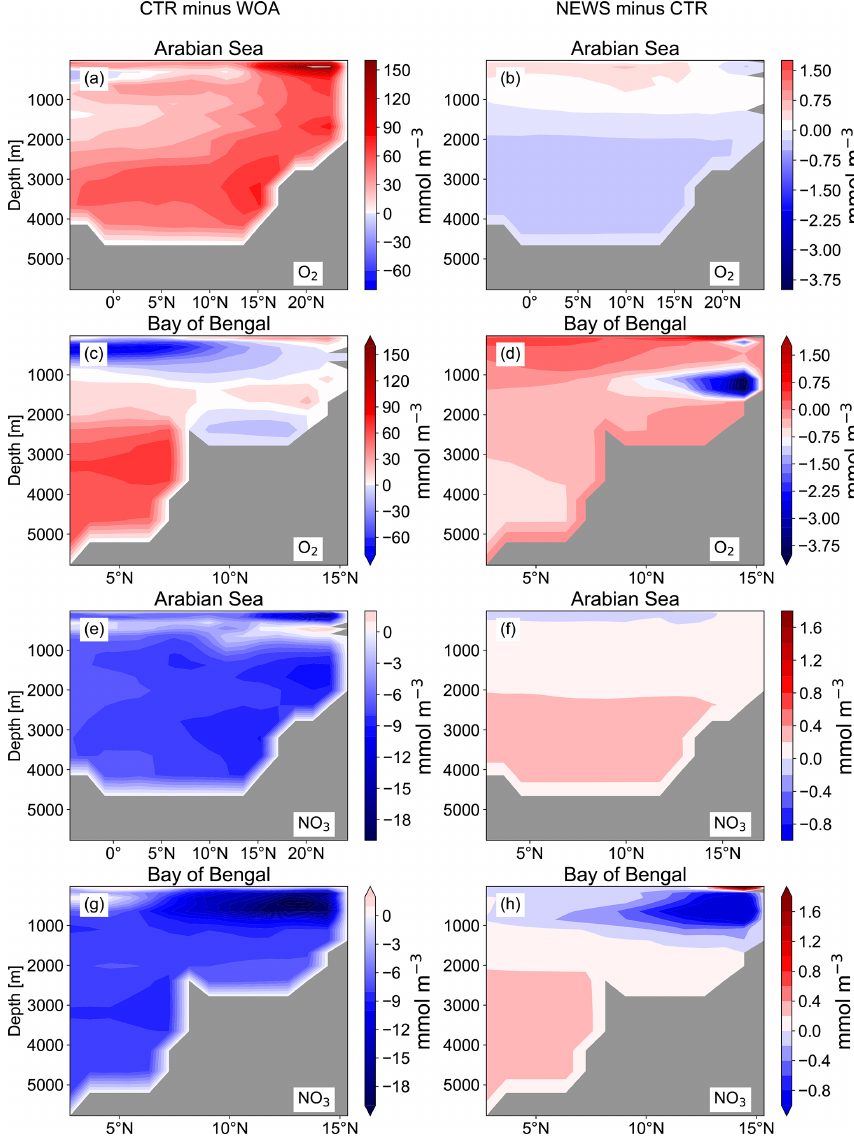
Figure 7. Difference in zonal average of NO 3 and O 2 in the basins of the Arabian Sea (a, b, e, f) and the Bay of Bengal (c, d, g, h) . The panels in the left column show the difference between CTR and the World Ocean Atlas (WOA), and in the right column the difference between NEWS and CTR is shown. All results are shown in mmolm − 3 . Table 3. Global nitrogen sources (river supply, N 2 fixation) and sinks (denitrification) averaged over the last 100 years of the simulations. All fluxes are given in TgNyr − 1 . Note that the global sums from sources and sinks do not exactly add up to zero due to natural variability in the modeled N